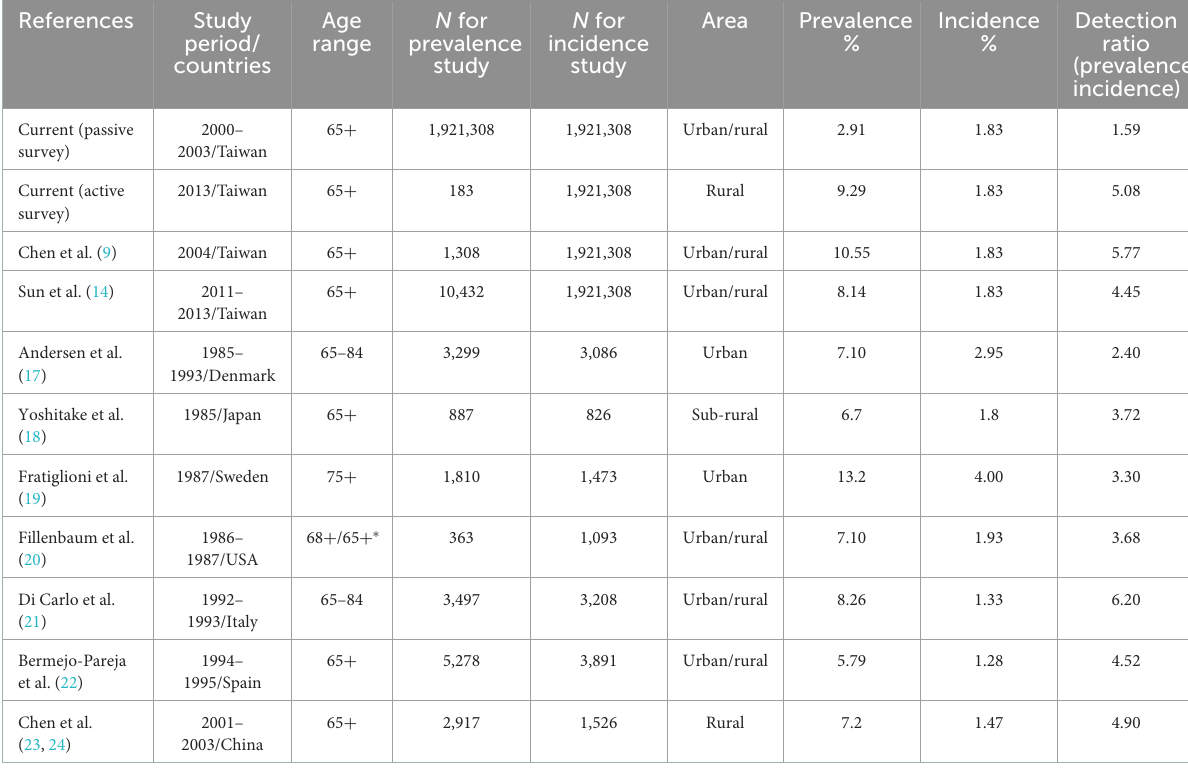
TABLE 5 Prevalence, incidence, and ratio of dementia in Taiwan and other community-based